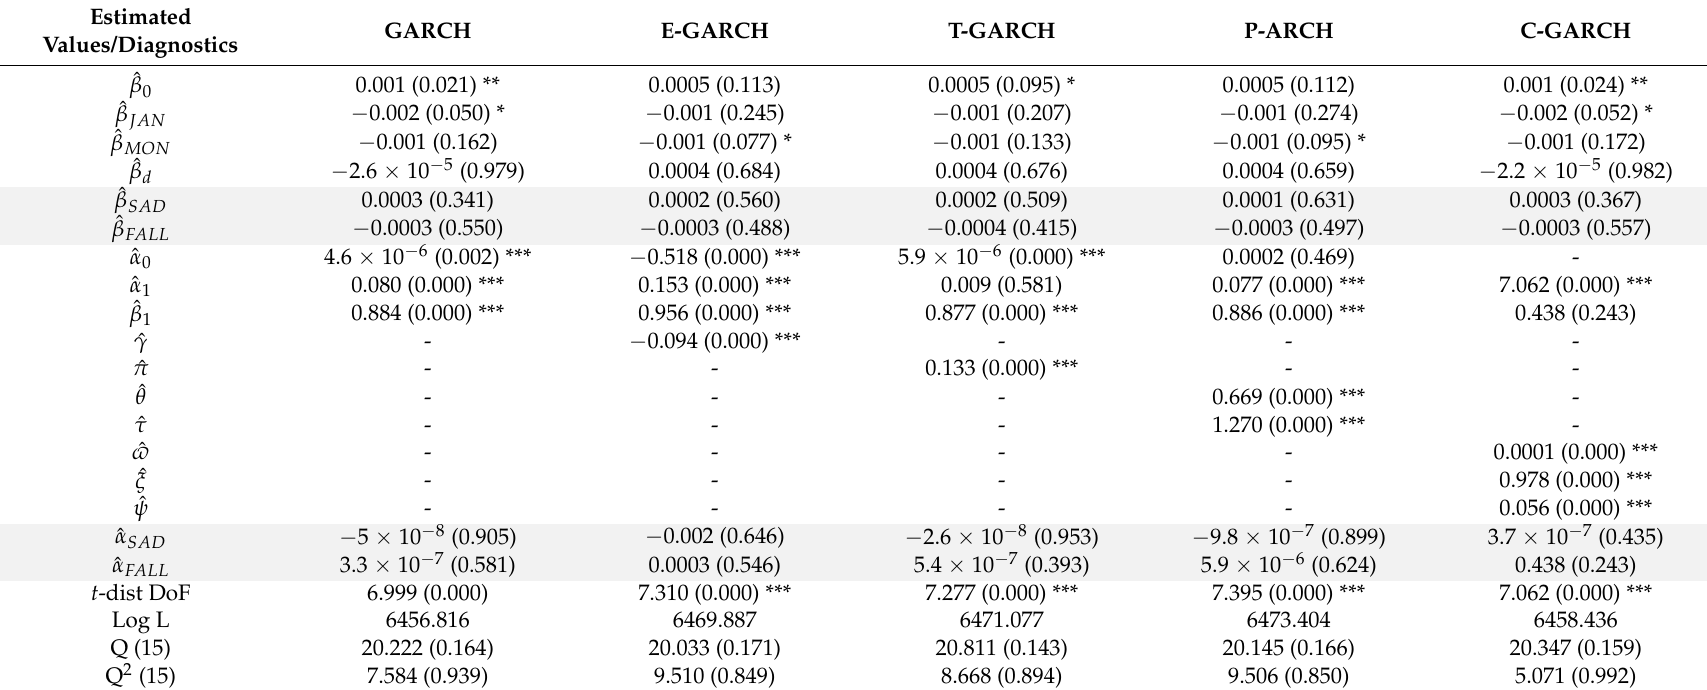
Table A7. Different GARCH specifications for